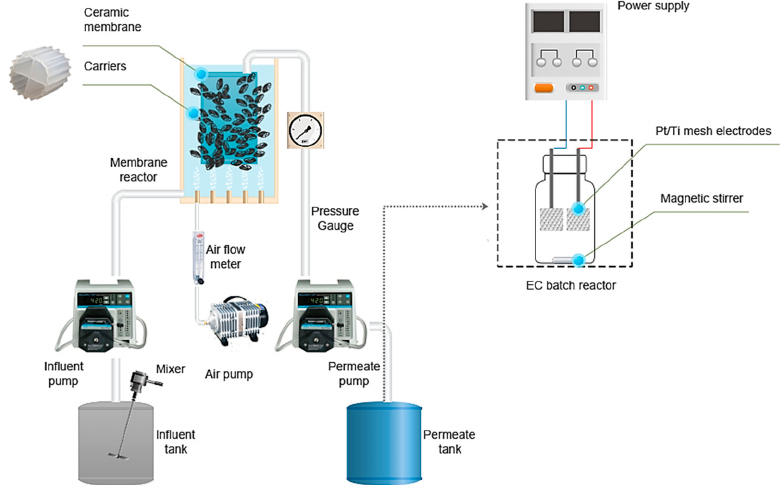
Figure 1. Schematic diagram of the MBMBR–EC experimental set-up.